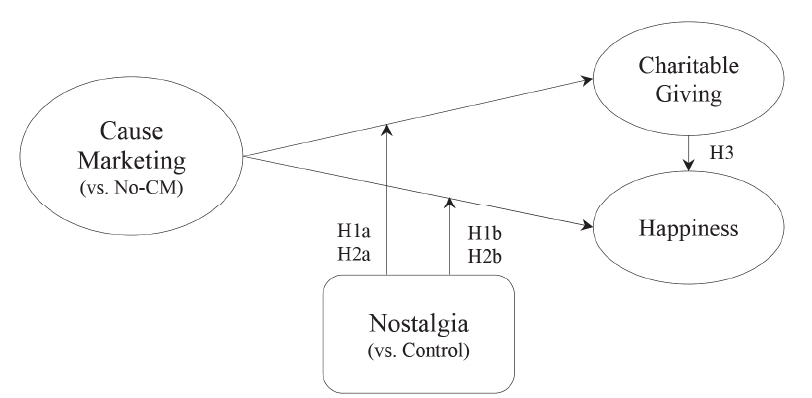
<Figure 1> Conceptual model for the interaction effect of cause marketing and